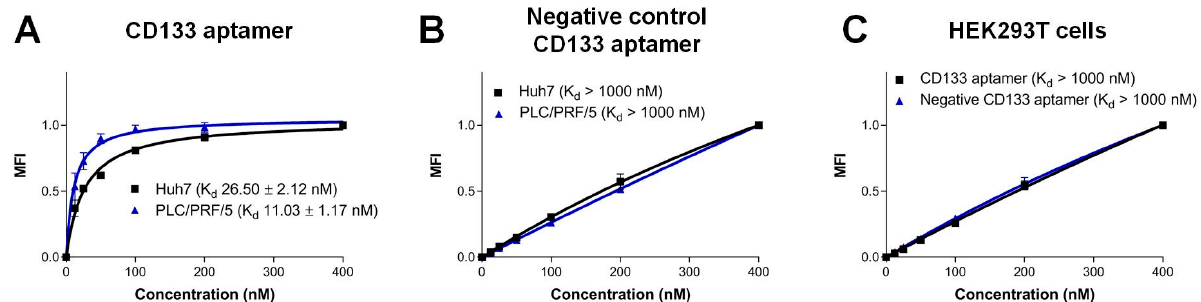
Figure 2. Characterization of the specificity of the CD133 aptamer. Alexa Fluor 647-labeled CD133 aptamers were incubated with indicated human cells and analyzed by flow cytometry . The median fluorescence intensity (MFI) was plotted against varying concentrations of CD133 aptamer (1–400 nM). ( A ) Binding of CD133 aptamer to CD133-positive Huh7 and PLC/PRF/5 cells. ( B ) Binding of the negative control CD133 aptamers to Huh7 and PLC/PRF/5 cells. ( C ) Binding of CD133 aptamers to CD133-negative HEK293T cells. Data shown are means ± SD, ( n = 3).